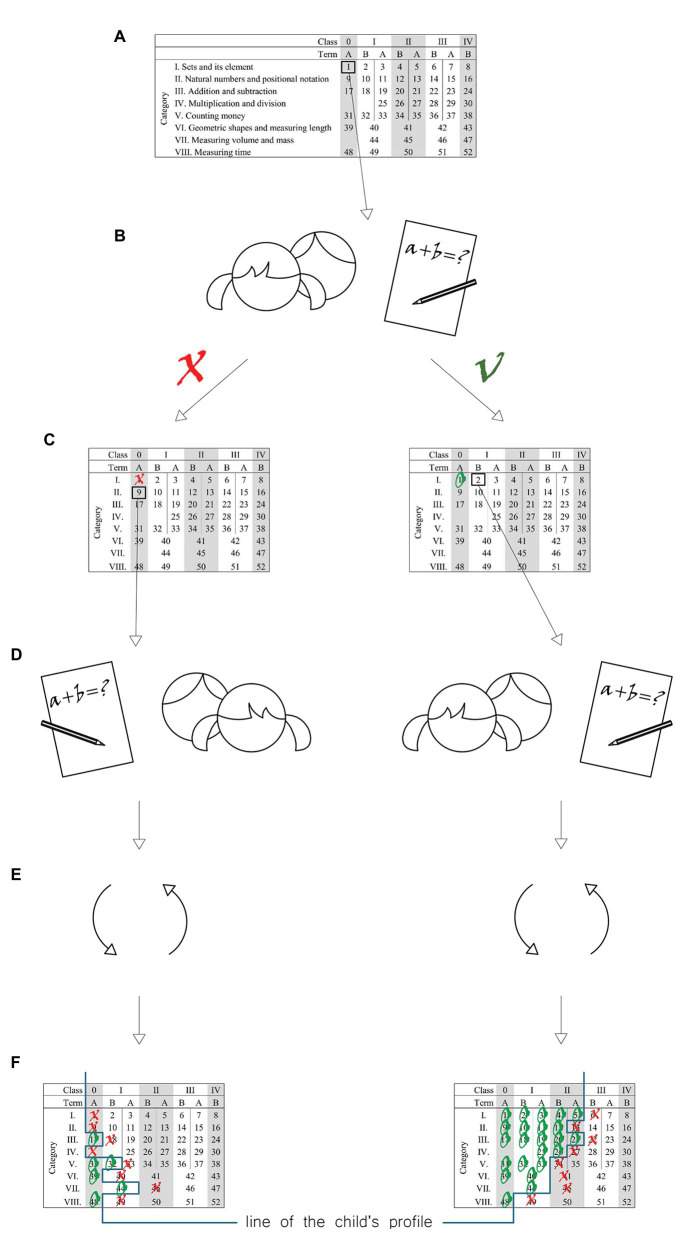
Structure of the mathematical test procedure. (A) The child begins to take the test from the first category task at the zero (0) level. (B) Each time the child solves a task, the task is marked in the plane with a circle, whereas an improperly solved task is crossed out. (C,D) If the task is solved properly, the child is FIGURE 2asked to solve another task (more difficult) in the category. (E) This procedure should be repeated until the task turns out to be too difficult: this helps to determine the upper limit of the child’s abilities to independently solve the task. In the case of the task not solved in the primary series, the child solves the task in the next category. (F) After the result of the independent work of the child is marked in the test plan, the profile of child’s abilities to solve tasks independently is determined (the line of the profile runs exactly between the circles and crosses).